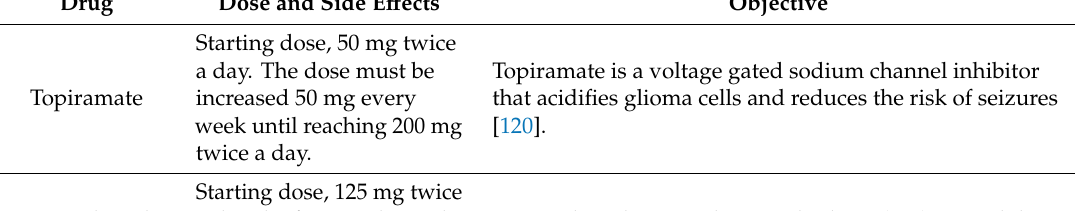
Table 2. Drugs with a potential benefit in the treatment of malignant brain tumors that, to a large extent, have not yet been clinically or even preclinically